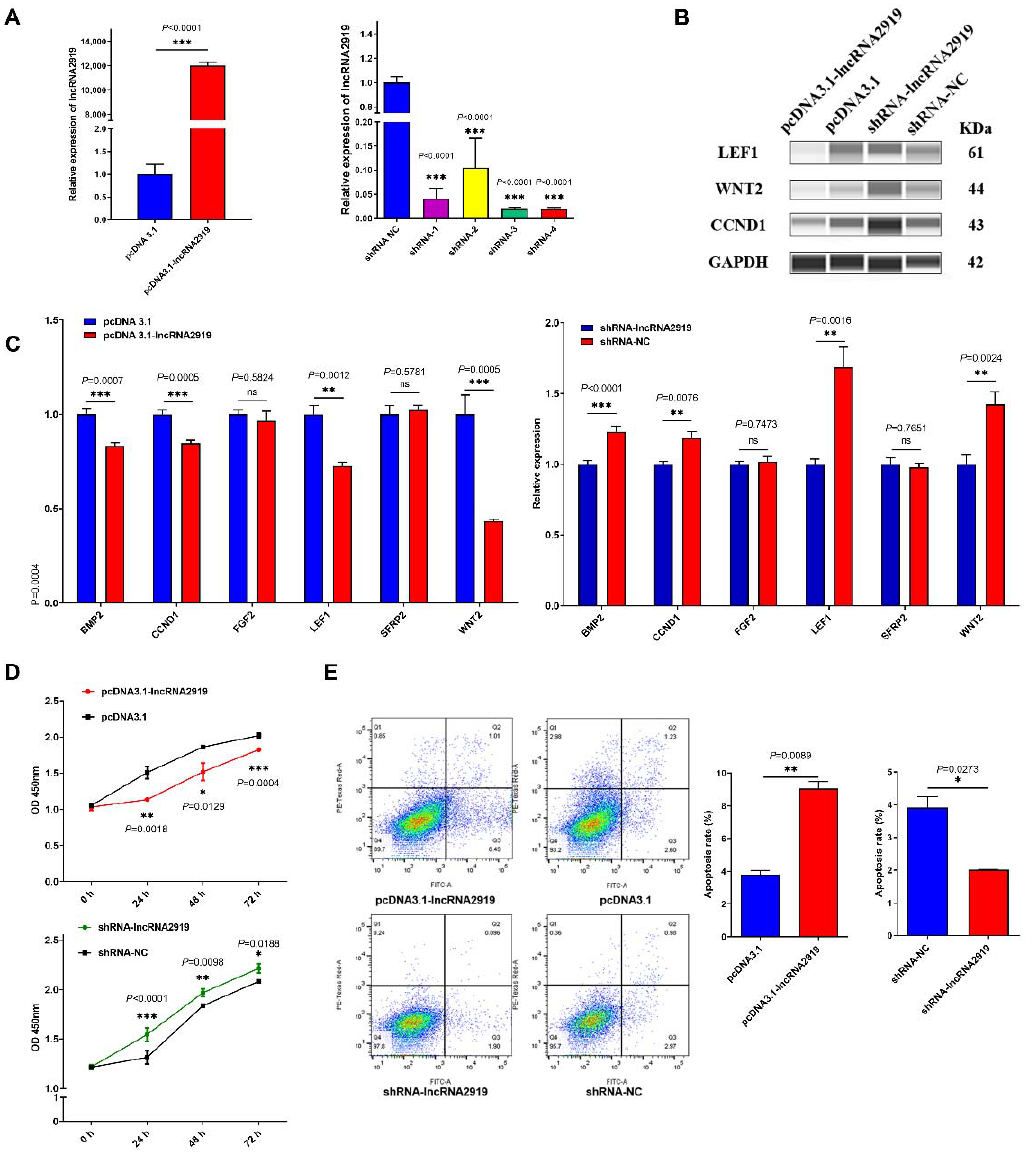
Figure 2. Negative role of lncRNA2919 in HF cycling and growth. ( A ) lncRNA2919 expression was detected after lncRNA2919 overexpression and knockdown in DPCs. ( B ) lncRNA2919 regulated the expression of HF cycling and growth-related proteins after lncRNA2919 overexpression and knockdown in DPCs. ( C ) lncRNA2919 regulated the mRNA expression of HF cycling and growth-related genes after lncRNA2919 overexpression and knockdown in DPCs. ( D ) lncRNA2919 inhibited the proliferation of DPCs. ( E ) lncRNA2919 promoted the apoptosis of DPCs. Data are presented as mean ± SEM, ns indicates not significant. A two-tailed paired t -test was used for data analyses.